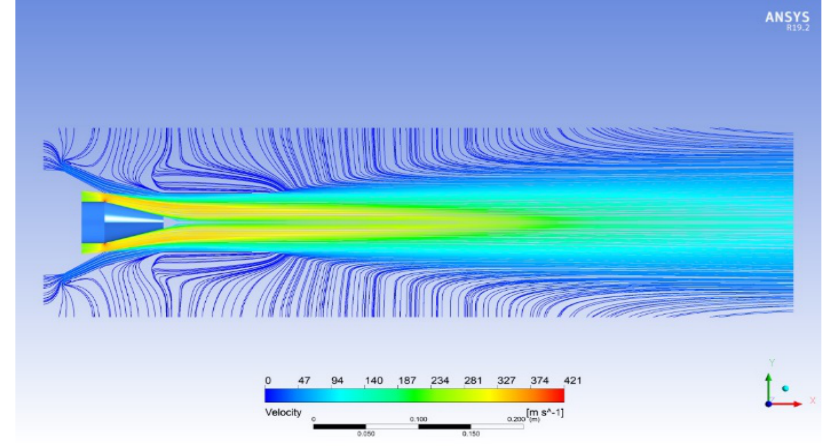
Figure 11. Velocity field and streamlines for the case when section 5 has a value of 11 mm.